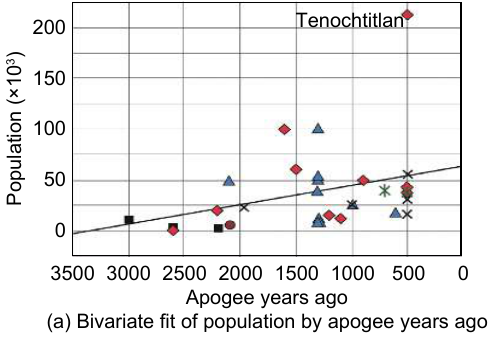
(b) Bivariate fit of writing indexes by apogee years